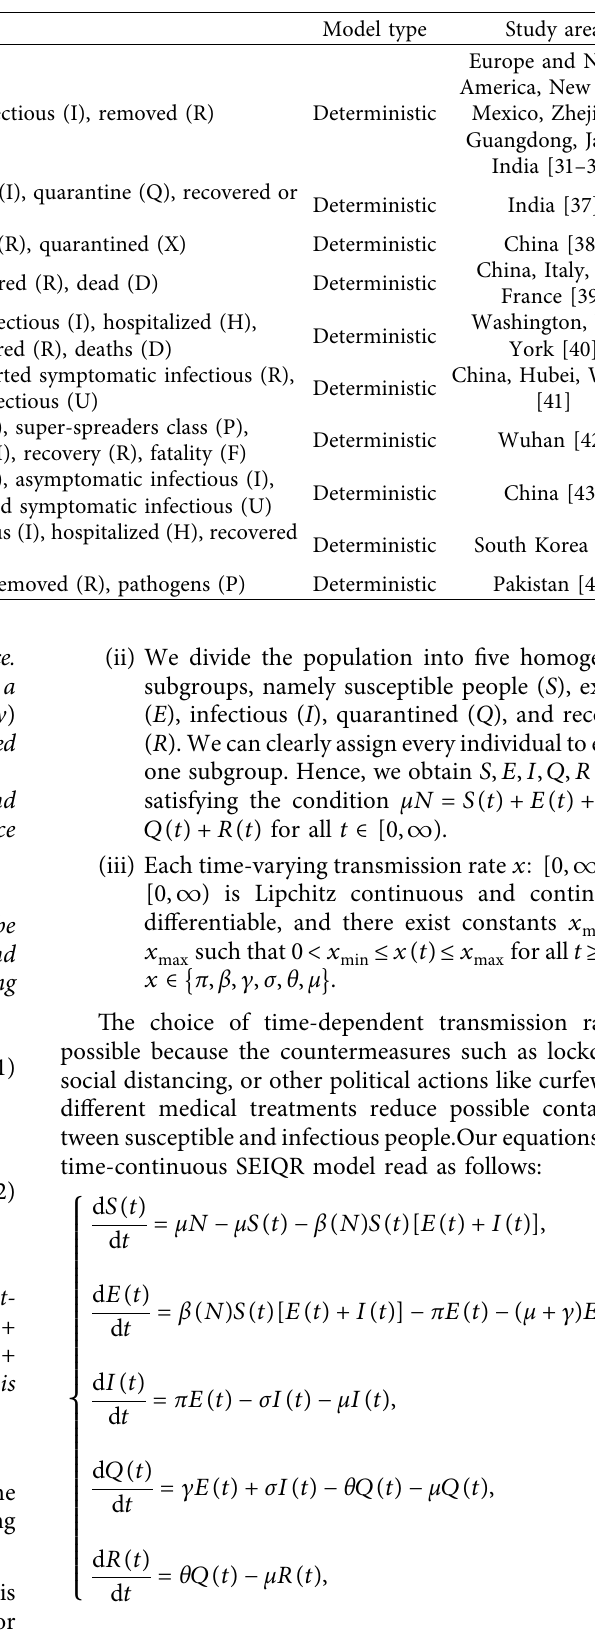
Table 1: Overview of models